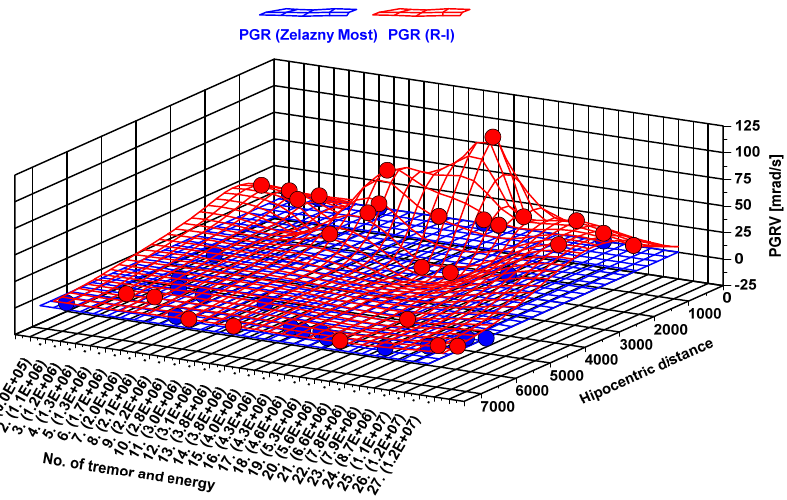
Figure 13. Comparison of PGRV recorded at Zelazny Most (blue) and near the Rudna-I shaft (red).